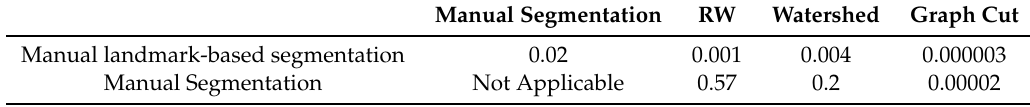
Table 3. Statistical significance results between manual and automated cartilage-thickness measurements.